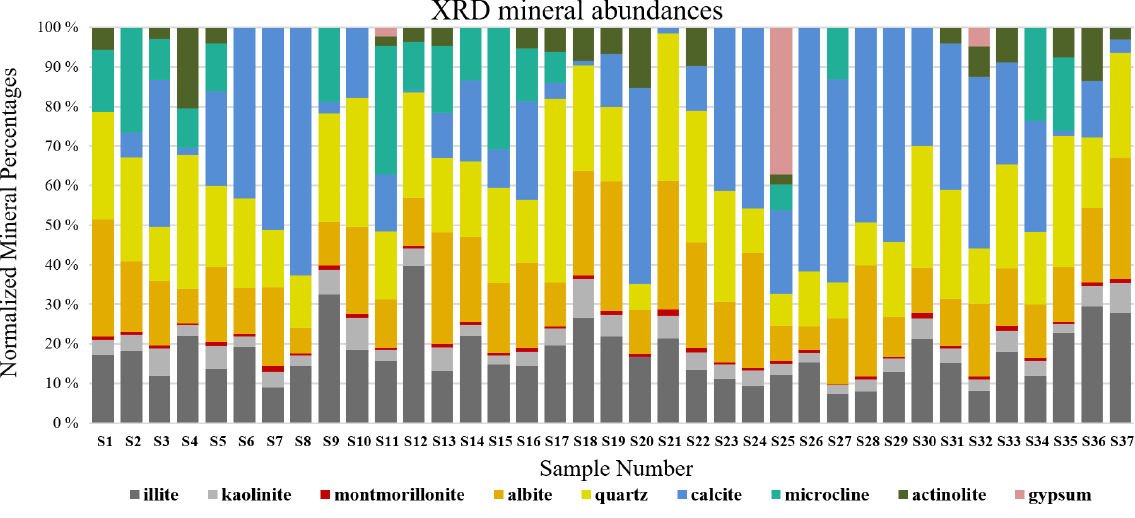
Figure 8. Bar charts demonstrate the relative phase concentration (wt%) calculated from the total diffracted peak area of various minerals obtained by XRD